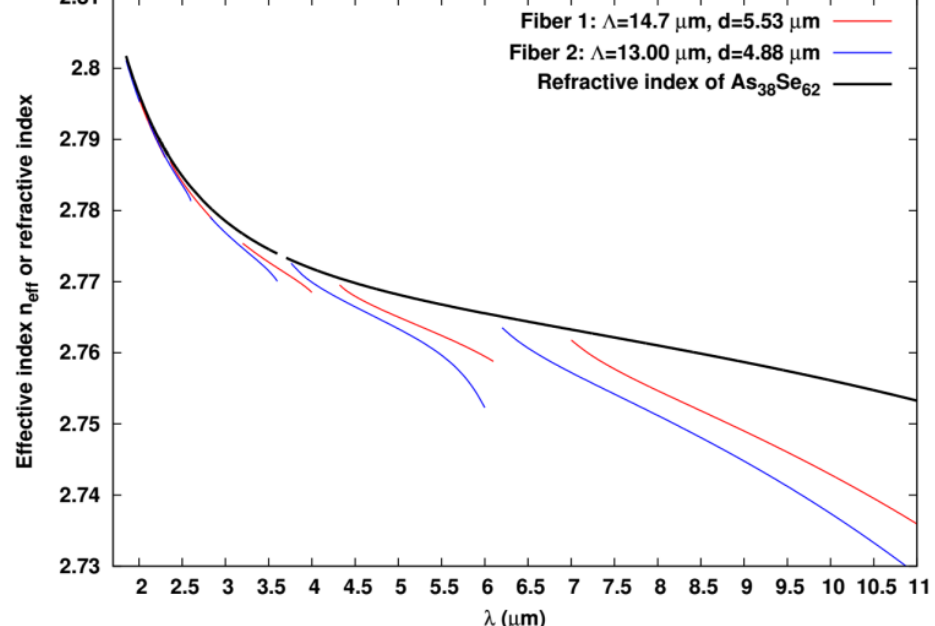
Figure 6. Material dispersion for the matrix As computed effective index of the fundamental core localized mode for Fibers 1 and 2 as a function of the wavelength.